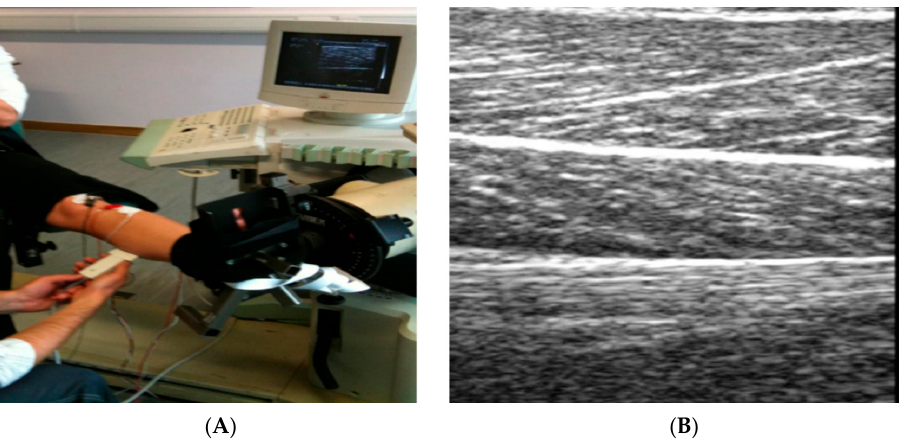
Figure 8. ( A ) Application of ultrasound and equipment involved; ( B ) Example of a grey scale image produced by an Ultrasound when placed directly upon skeletal muscle.